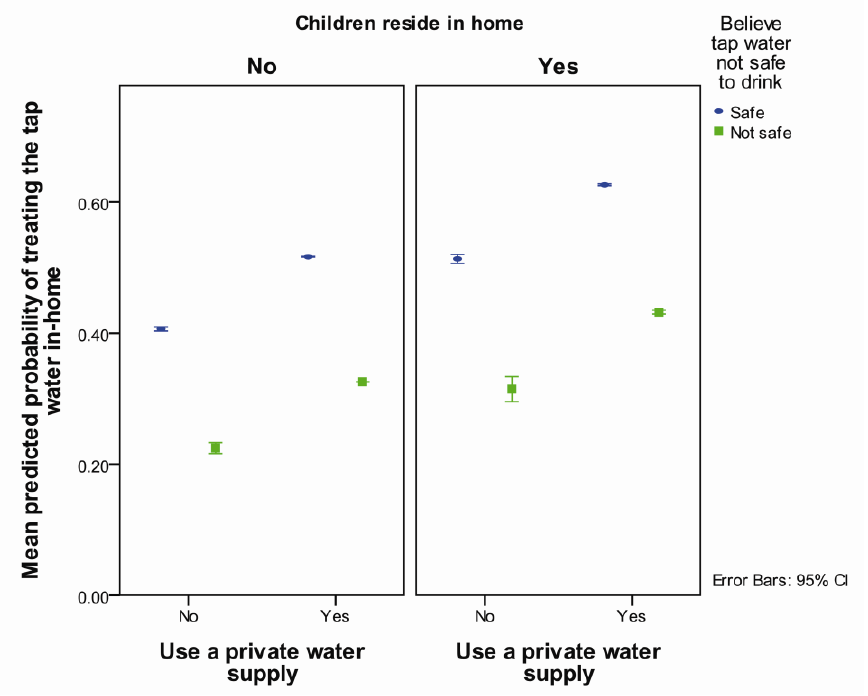
Figure 5. Predicted probability of treating tap water in-home by use of a private water supply and the belief that tap water is not safe to drink, separated by whether or not children reside in household, adjusted for whether the home was in a town and whether a community water supply was used.